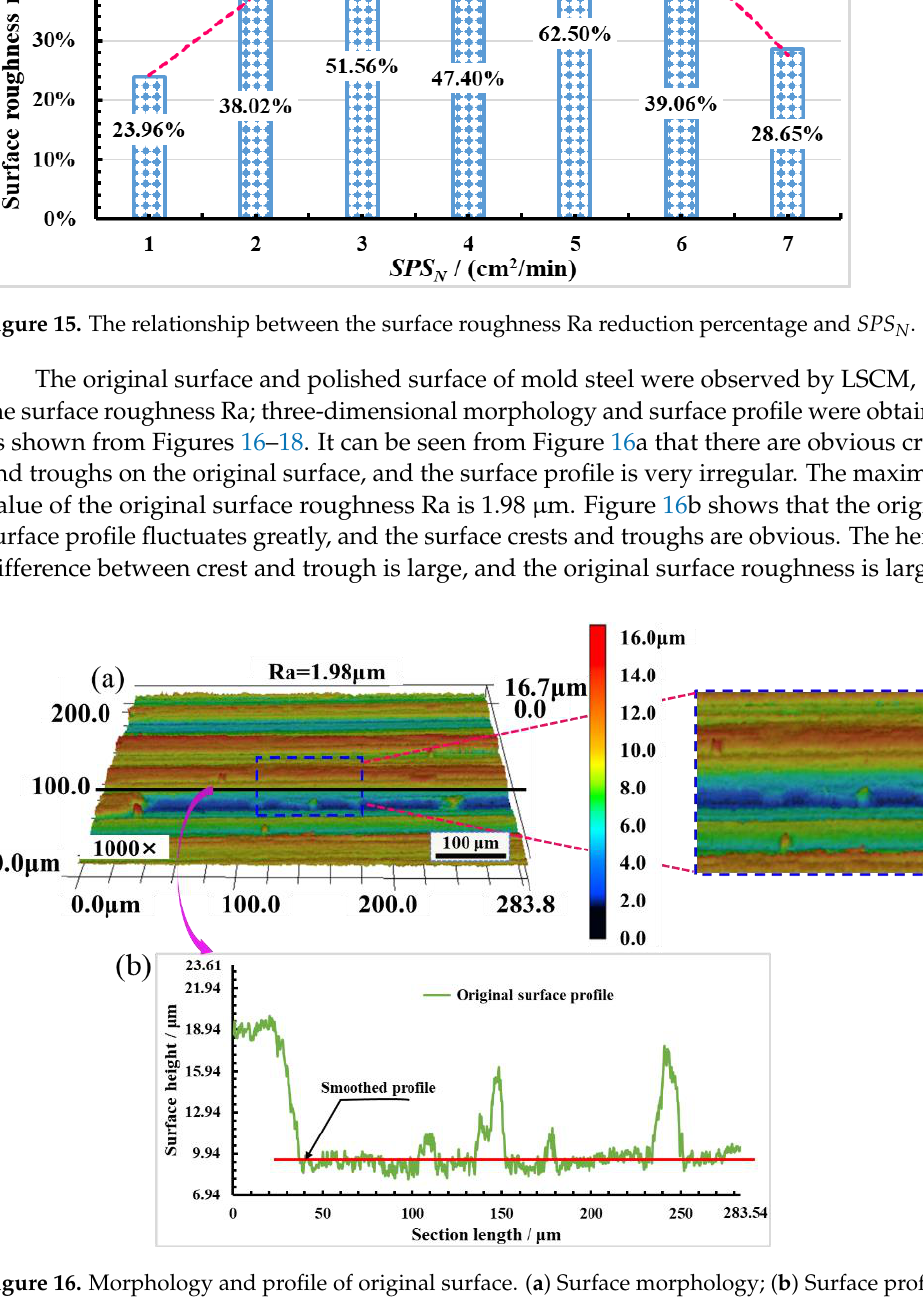
Figure 16. Morphology and profile of original surface. ( a ) Surface morphology; ( b ) Surface profile.